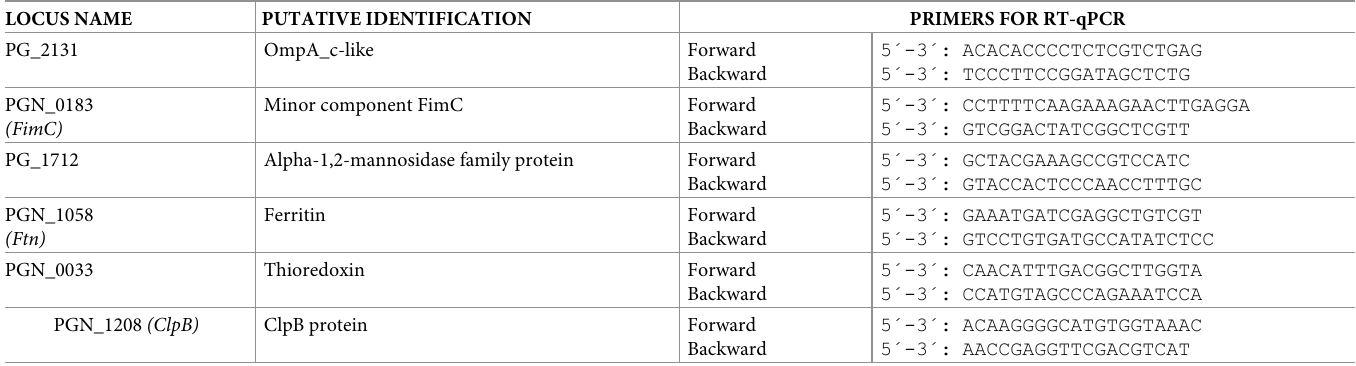
Table 1. Primers used for Reverse Transcription-quantitative Polymerase Chain Reaction